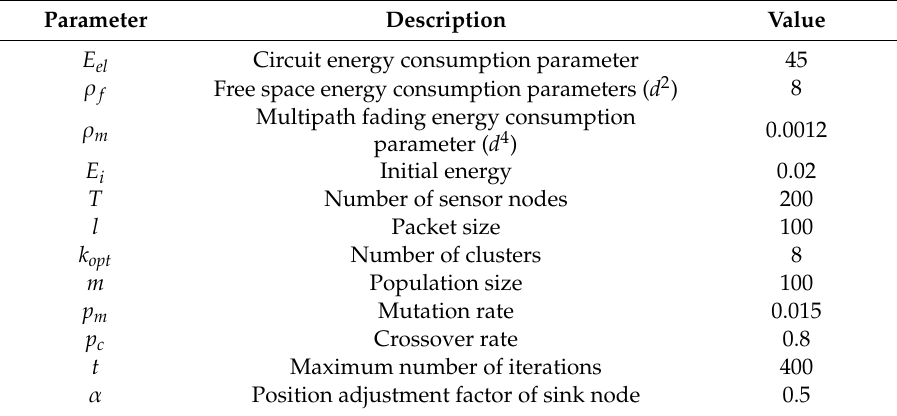
Table 1. Simulation parameters of routing protocol based on clustering